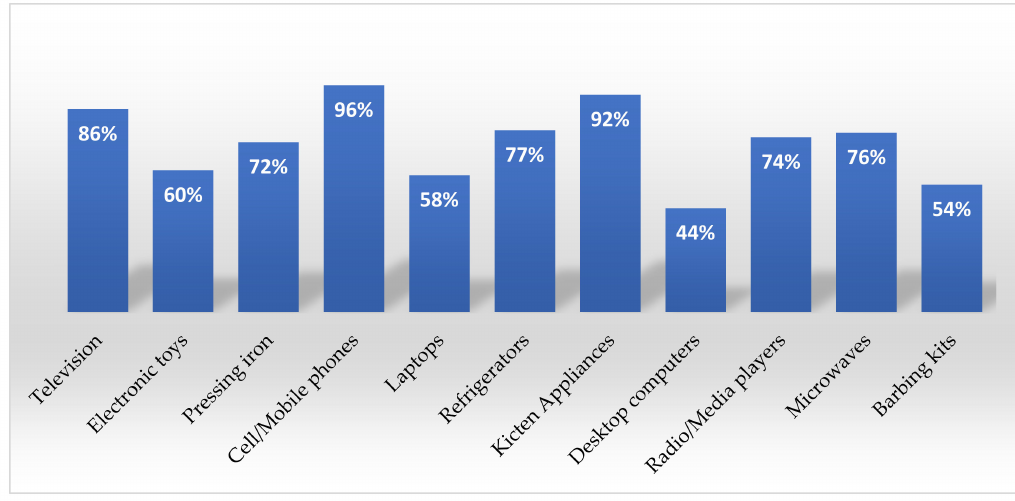
Figure 2. Percentage of some of the electronic devices owned by households in the survey.